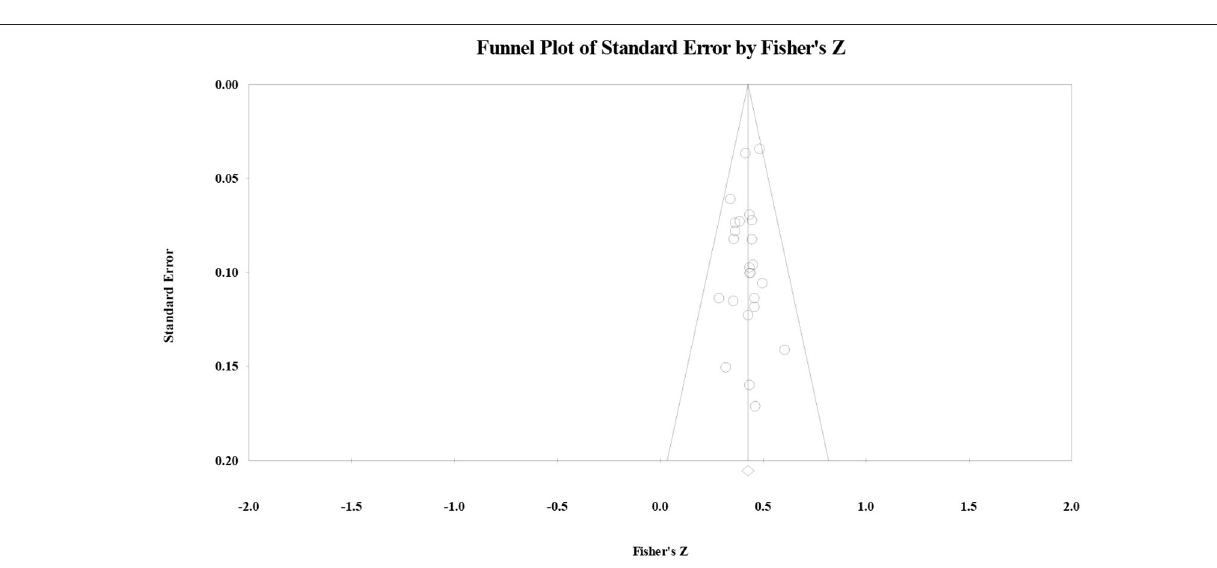
FIGURE 2 | Funnel plot of the correlation between the elaboration strategy and reading